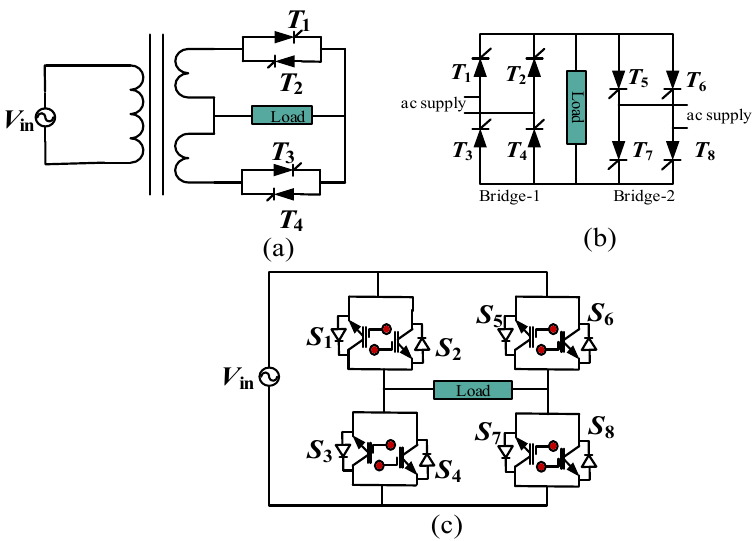
Figure 1 . Conventional cycloconverters (a) Biswas [10], (b) Agarwal [11] (c) Agarwal [12] (1/3) and Figure 1. Conventional cycloconverters ( a ) Biswas [10], ( b ) Agarwal [11] ( c ) Agarwal [12] (1/3) and (1/4) frequency conversion of 50 Hz. (1/4) frequency conversion of 50